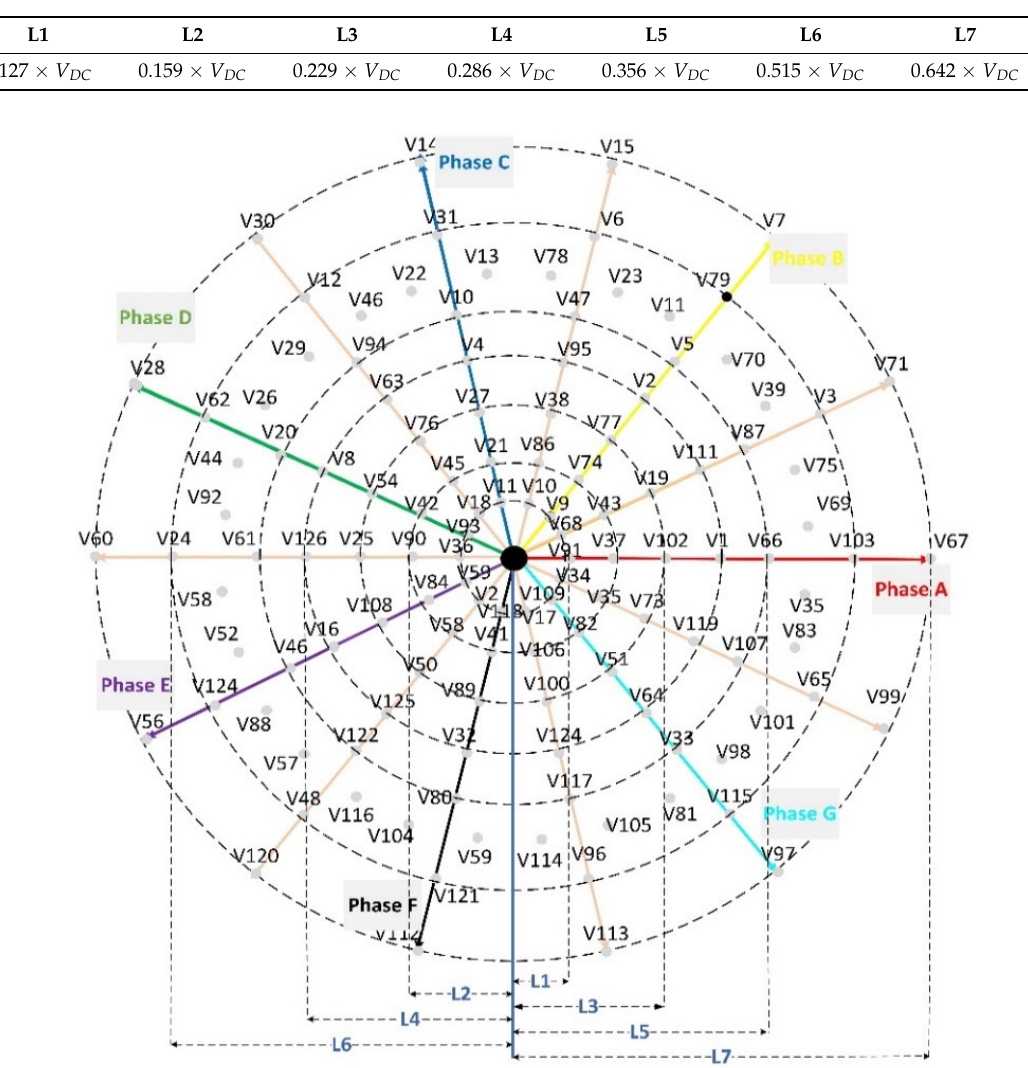
Figure 2. Voltage vector space distribution in the x1-y1 plane.